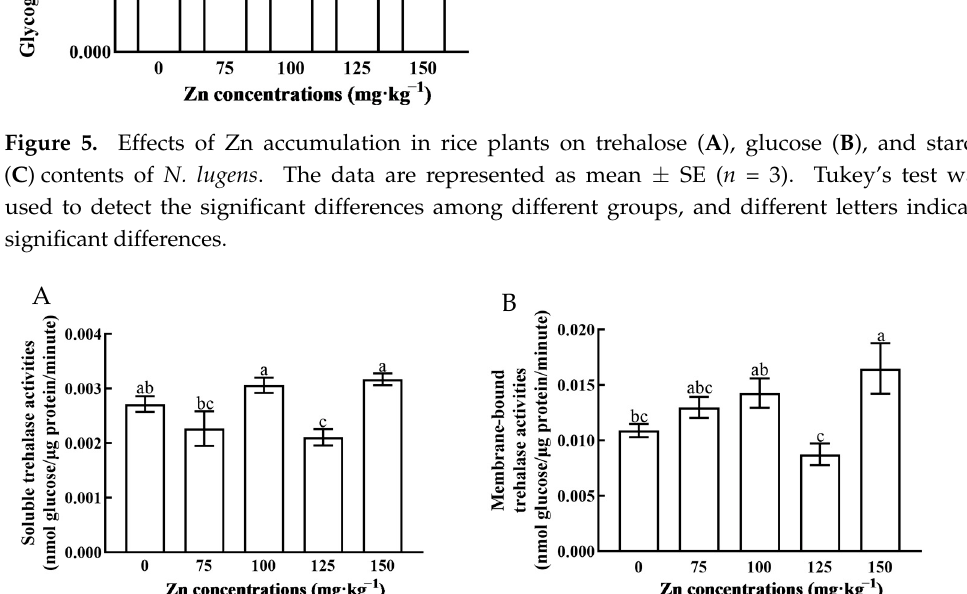
A B Figure 7. Effects of Zn accumulation in rice plants on the expression of Tre ( A ) and Tps ( B ) in N. lugens . The qRT-PCR was used to determine the relative expression of genes, and actin was used as the internal control. The horizontal line in the figure represents the gene expression level in the control group. Data are represented as mean ± SE ( n = 3), and the significance of differences in gene expression between the treatment and control groups was analyzed with t-tests. * p < 0.05; ** p < 0.01. 4. Discussion Cd, As, and Zn are known to exhibit high mobility from soil to rice roots, indicating their high bioavailability [33]. Our study also indicated that the Zn content in soil signifi- cantly increased as Zn 2+ concentration increased in the irrigation water. Correspondingly, we found that the Zn accumulated in the rice plants treated with irrigation water with 100 mg·kg − 1 Zn 2+ concentration. However, unlike the hyperaccumulator plants, such as Sedum plumbizincicola [10,34], the rice plant has a limited uptake of Zn. According to the regres- sion analysis, we have speculated that when the concentration of Zn 2+ in irrigation water reaches a certain value, the accumulated Zn content in rice stems tends to be saturated, but it will not decrease significantly. Metal transporters, such as OsZIP1, promote the out- flow of Zn, Cu, and Cd metal ions in rice [35]. This might be the reason why the Zn accu- mulation in rice did not increase at higher Zn concentrations. However, the range of zinc